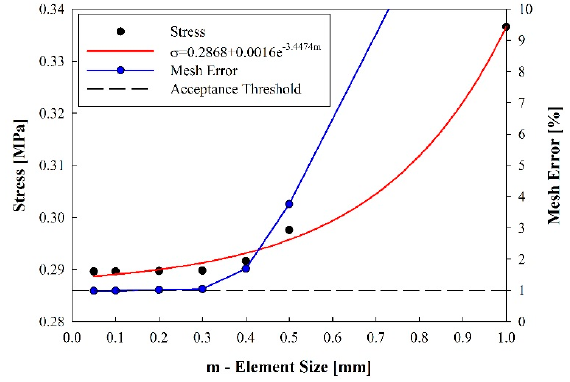
Figure 2. Mesh convergence analysis.